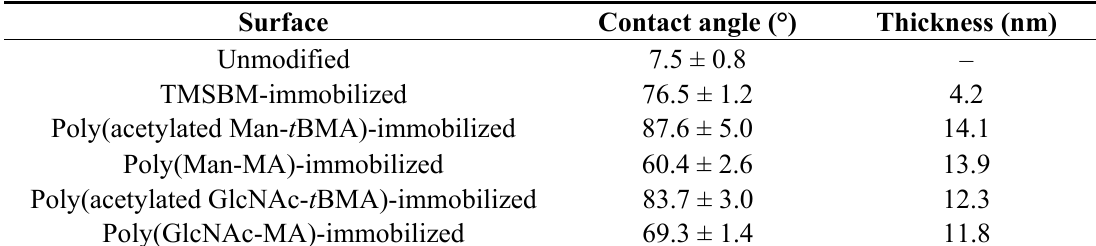
Table 2. Contact angles and polymer layer thicknesses of poly(glyco-MA)-immobilized silicon